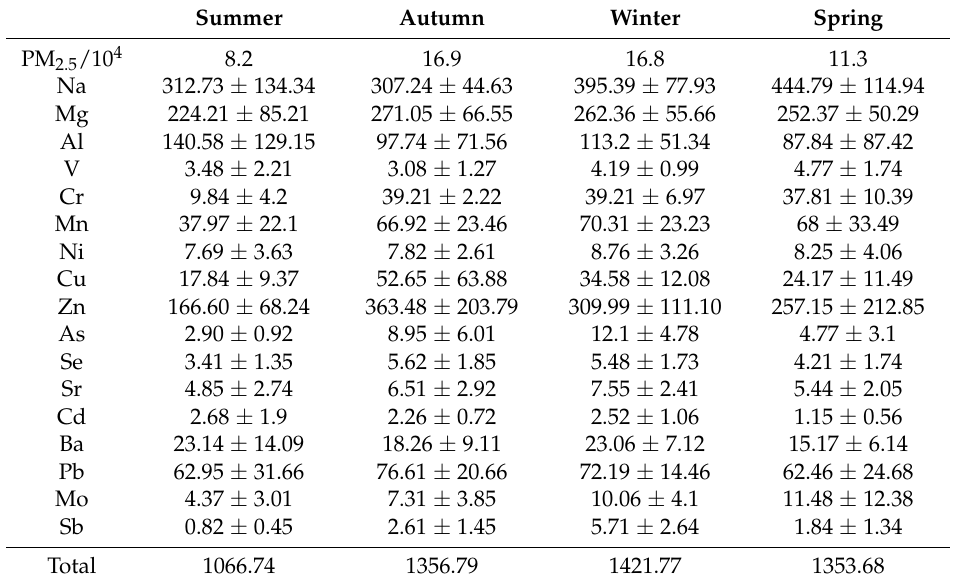
Table 3. Seasonal variations of atmospheric PM 2.5 metals (mean ± SD, ng/m 3 ) during the study period. (SD: Standard deviation). Summer Autumn Winter